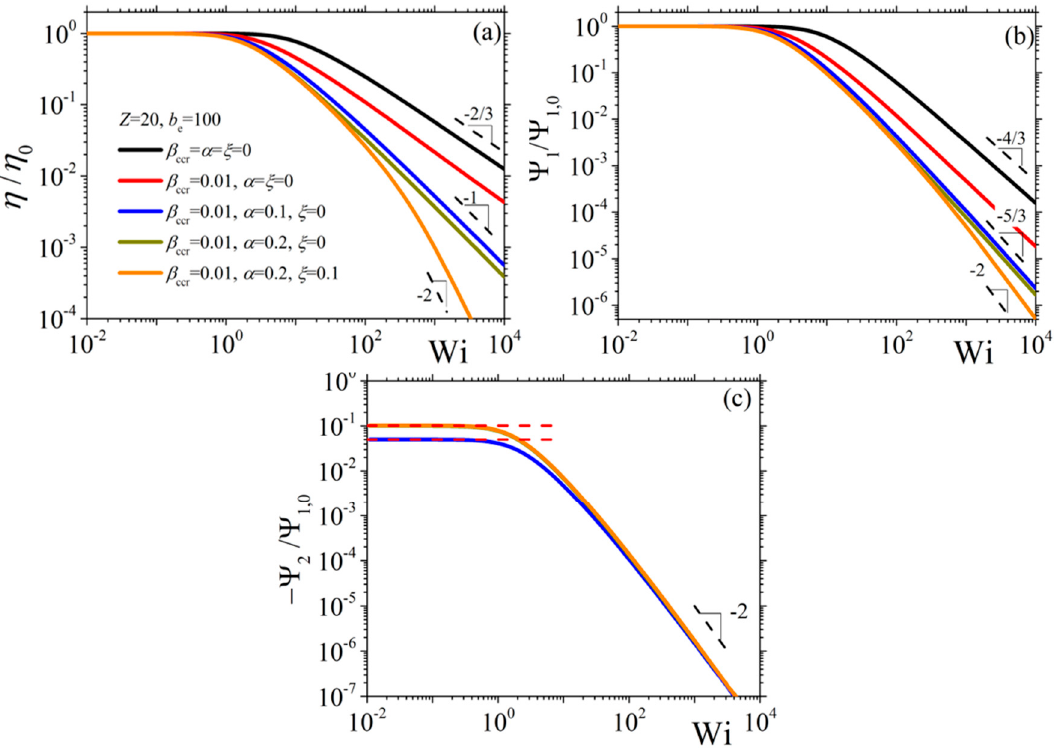
Figure 1. Model predictions for the three material functions (in scaled units) in shear, and dependence on the parameters α , ξ , and β ccr : ( a ) shear viscosity, ( b ) first normal stress coefficient, and ( c ) second normal stress coefficient [the red dashed lines depict the zero-rate value, Equation (16c)].